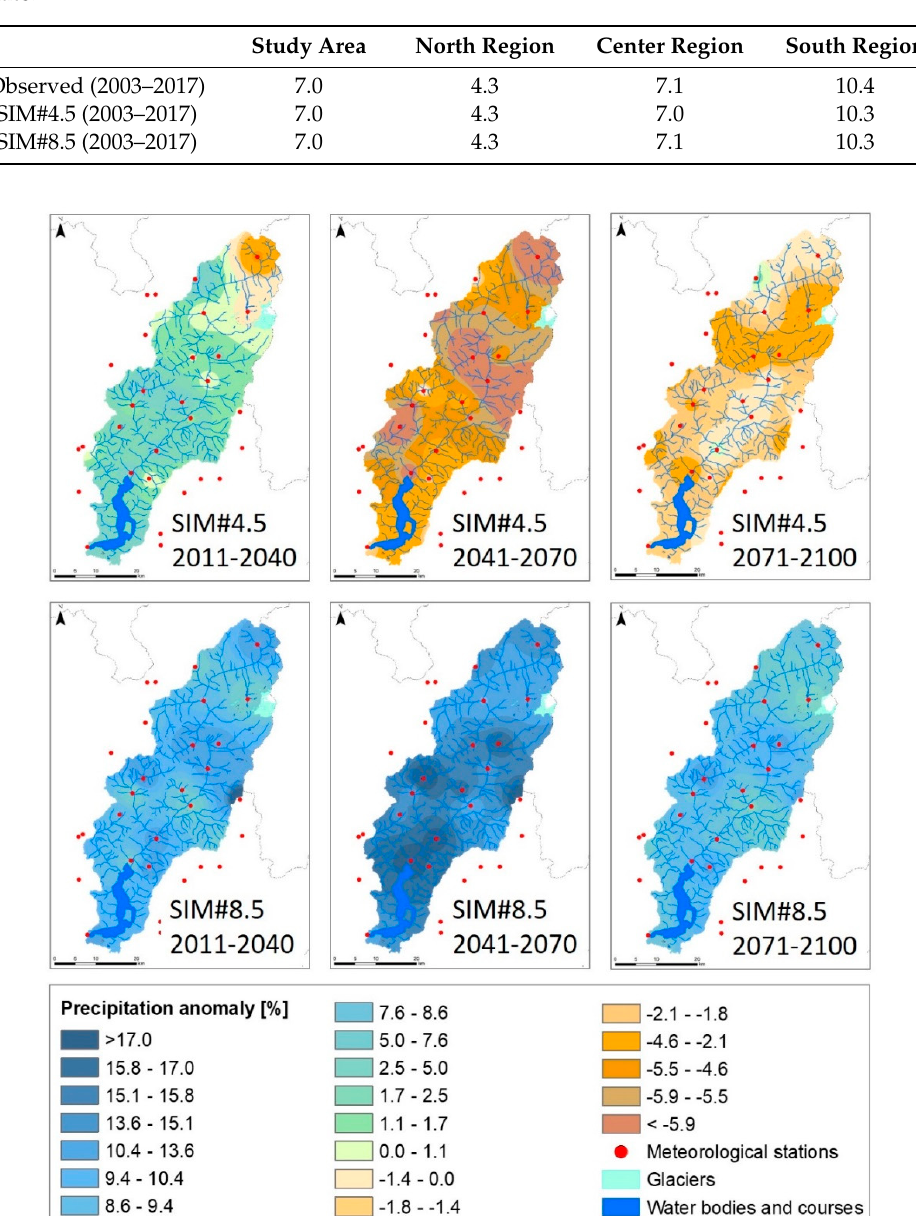
Figure 5. Mean precipitation anomalies compared to the reference period (1981–2010): simulated with SIM#4.5 (first row) and SIM#8.5 (second row) at 2011–2040 (first column), 2041–2070 (second column), and 2071–2100 (third column).